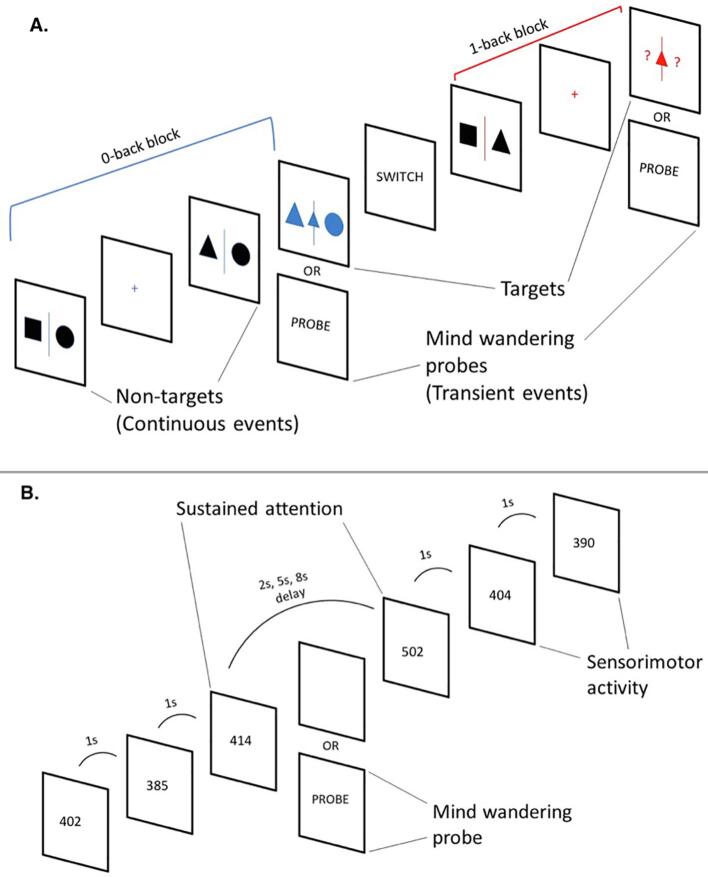
Schematic representation of the cognitive tasks. A. Mind Wandering Task: The Participants alternated between the two conditions. One condition involved observing two black shapes (non-target) before three blue shapes (target) appeared. At that point, the participant had to indicate which of the two side shapes matches the small blue shape in the middle (choice reaction, 0-back). In the 1-back condition, participants had to encode in working memory the two black shapes and when a small red shape with two red question marks on each side appears, they had to choose the left or right question mark based on the position of the black shape that is identical to the small red shape in the prior trial (working memory, 1-back) (Konishi et al., 2015). B. Sustained Attention task: The participants were asked to respond as fast as possible to the appearance of black-counters (participant’s reaction time) on the screen that count up in milliseconds. The counters appeared either after frequent and predictable delays of 1 s in blocks of 3–5 stimuli, or after unpredictable long delays of 2, 5 or 8 s, pseudo-randomly interspersed into the blocks of 1 s delays (Christakou et al., 2013). (For interpretation of the references to colour in this figure legend, the reader is referred to the web version of this article.)